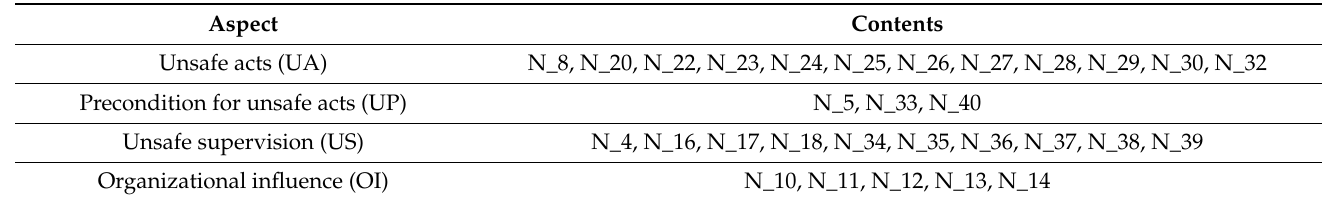
Table 5. HFACS framework for the identified hazardous